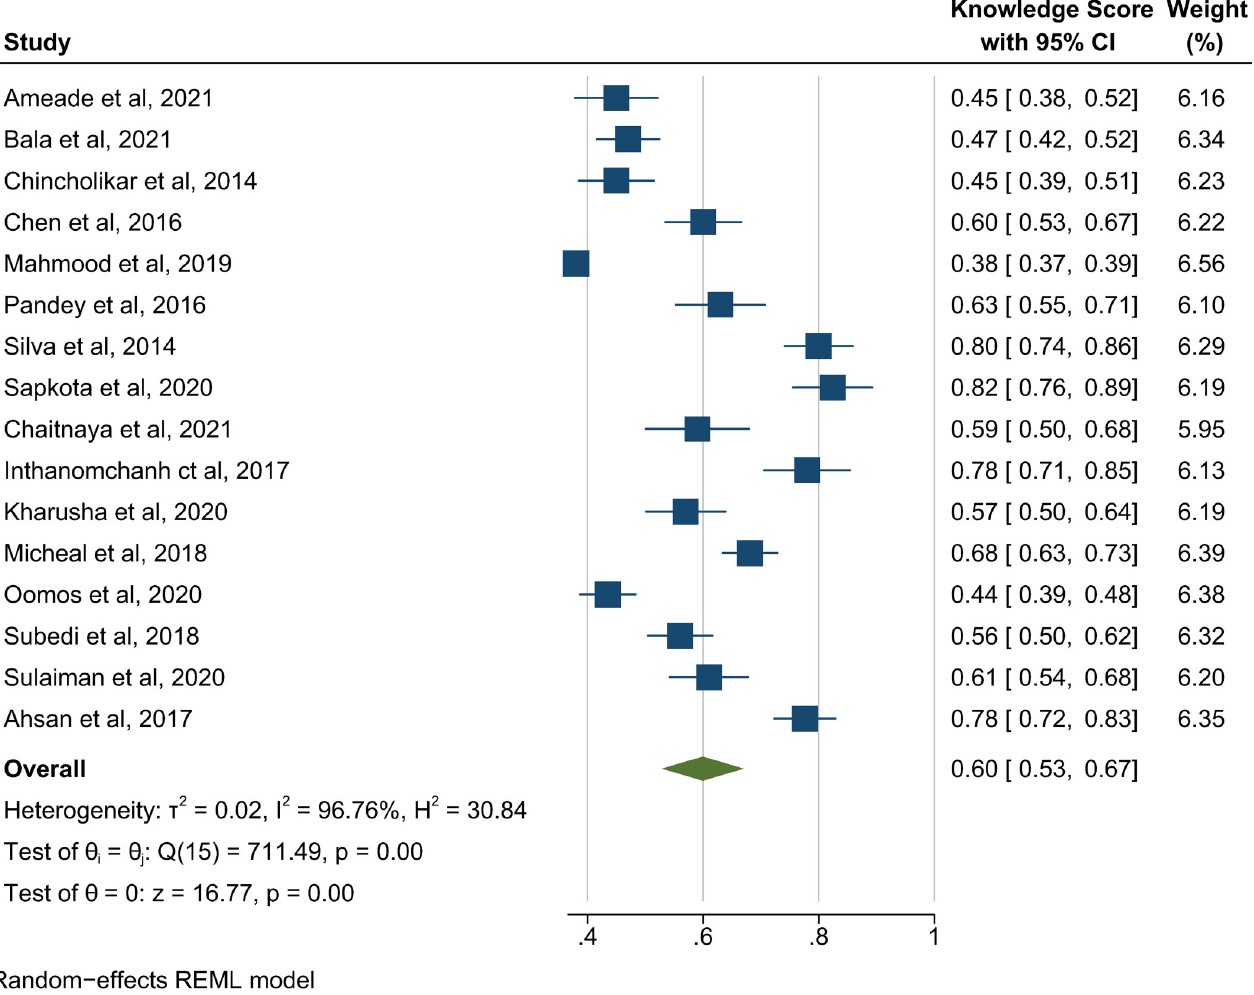
Fig 4. Pooled proportion of knowledge about snakebite of the 6 key domains, REML-Restricted Maximum Likelihood